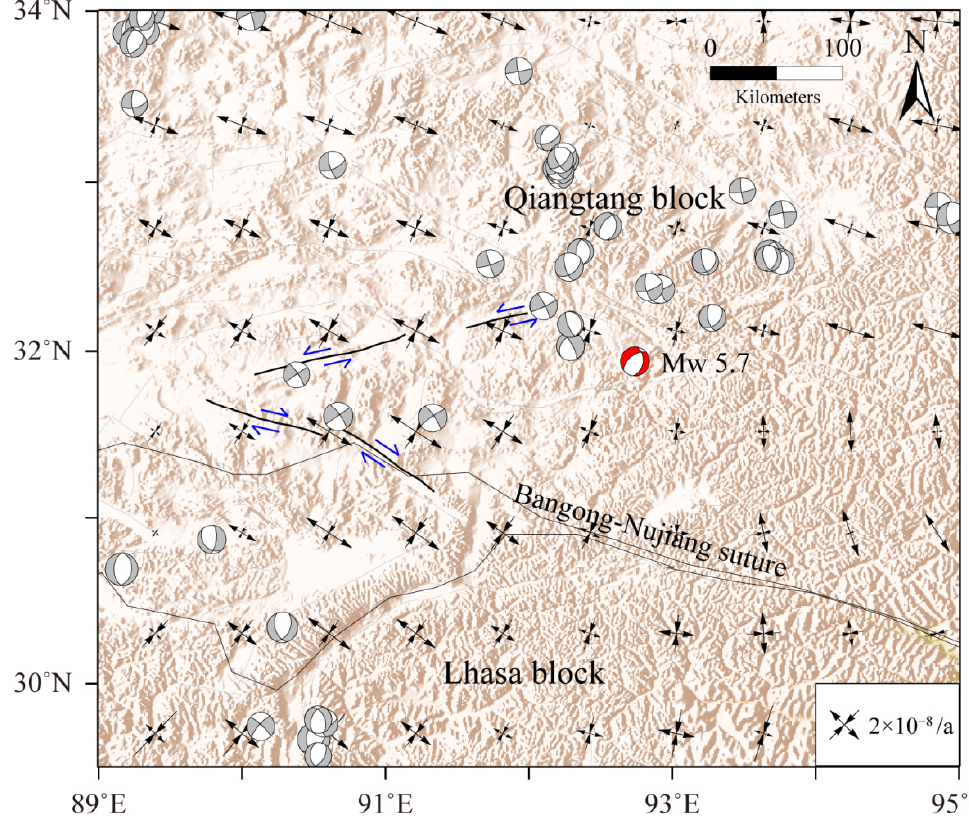
Figure 8. Conjugate strike-slip fault systems, focal mechanism solutions, and principal strain rate. Gray beach balls and red beach balls are those taken from the Global Centroid Moment Tensor catalog (M ≥ 5.0) and the Nakchu earthquake in this study, respectively. The black arrow pairs represent GPS-derived principal strain rates.